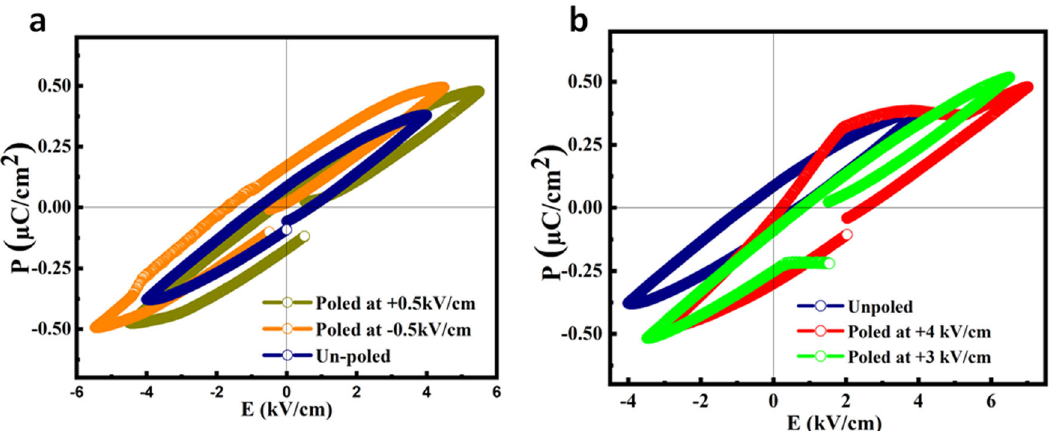
Fig. 4 Poled and un-poled ferroelectric effect. a P – E hysteresis loop of un-poled and poled sample at ±0.5 kV/cm electric fi eld. b Un-poled and poled sample at + 3 and + 4 kV/cm electric fi eld at 100 Hz frequency of HT-Ti 3 C 2 T x MXene fi lm measured at room